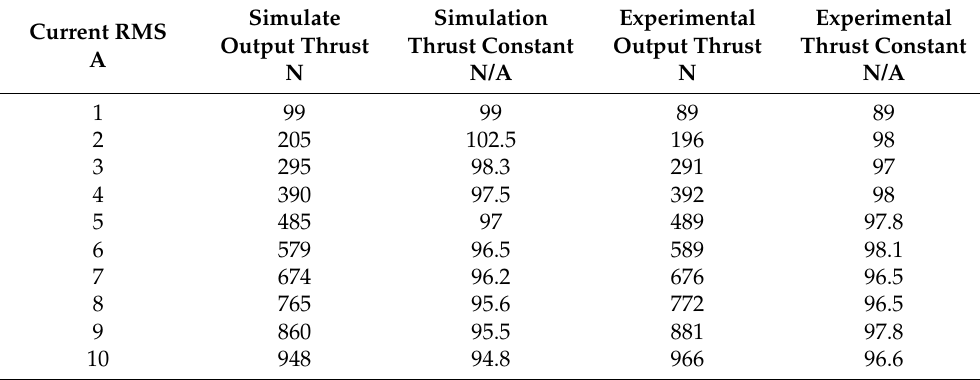
Table 2. Comparison of simulation and experimental output thrust at different